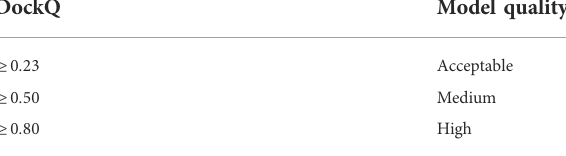
TABLE 1 Thresholds for DockQ measure of docked model